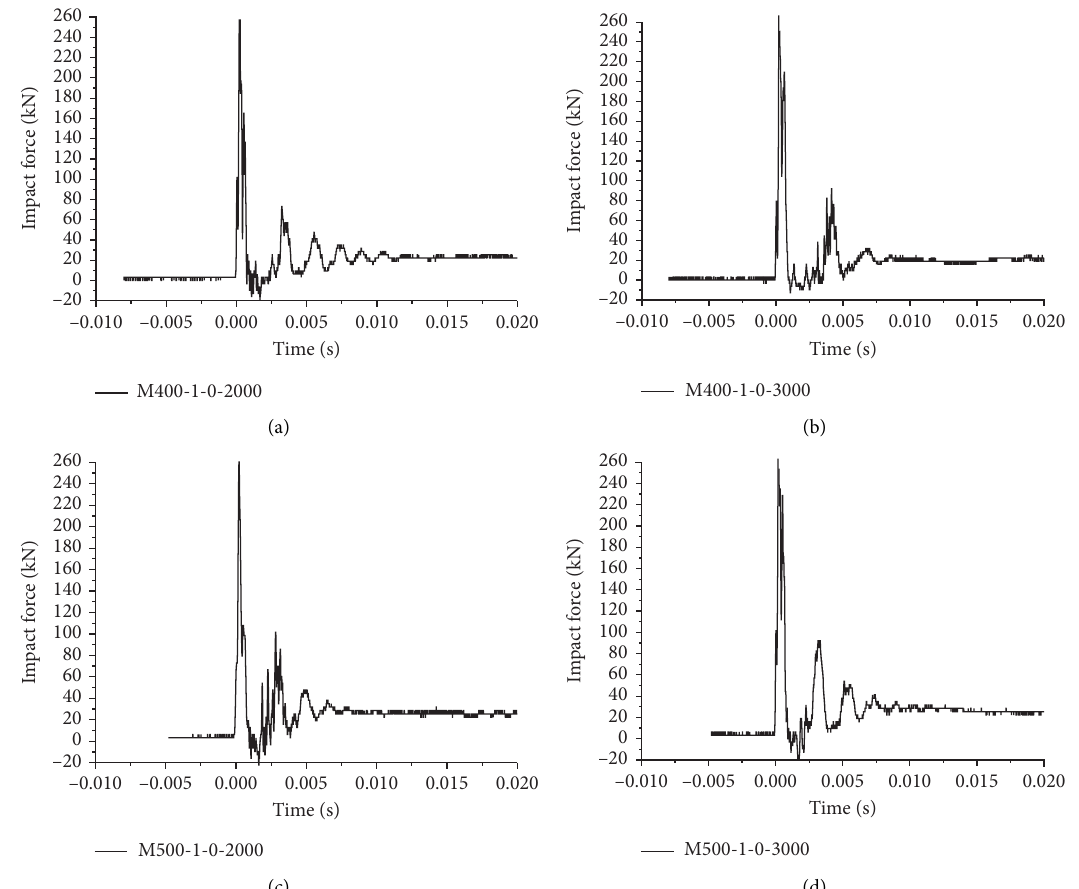
Figure 9: Time-history curves of the impact force of the bolted rock under different anchorage styles. (a) M400-1-0-2000. (b) M400-1-0- 3000. (c) M500-1-0-2000. (d)